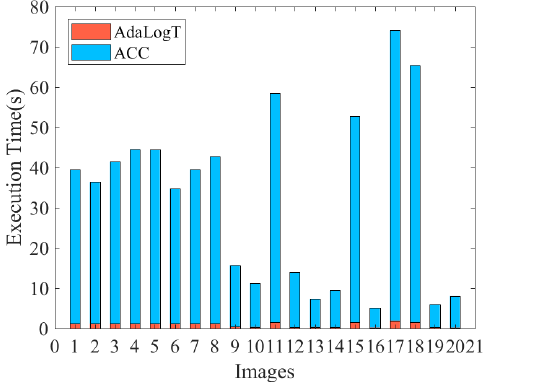
Figure 7. Comparison of ACC andAdaLogT image execution